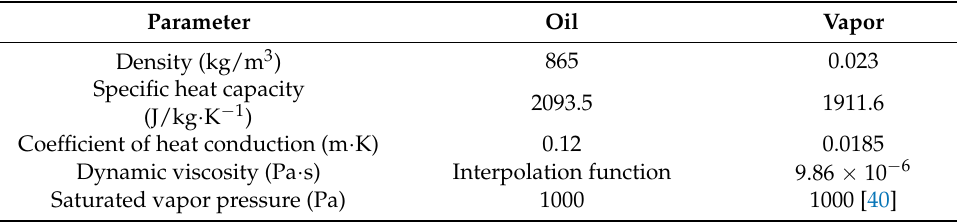
Table 3. Parameters of working